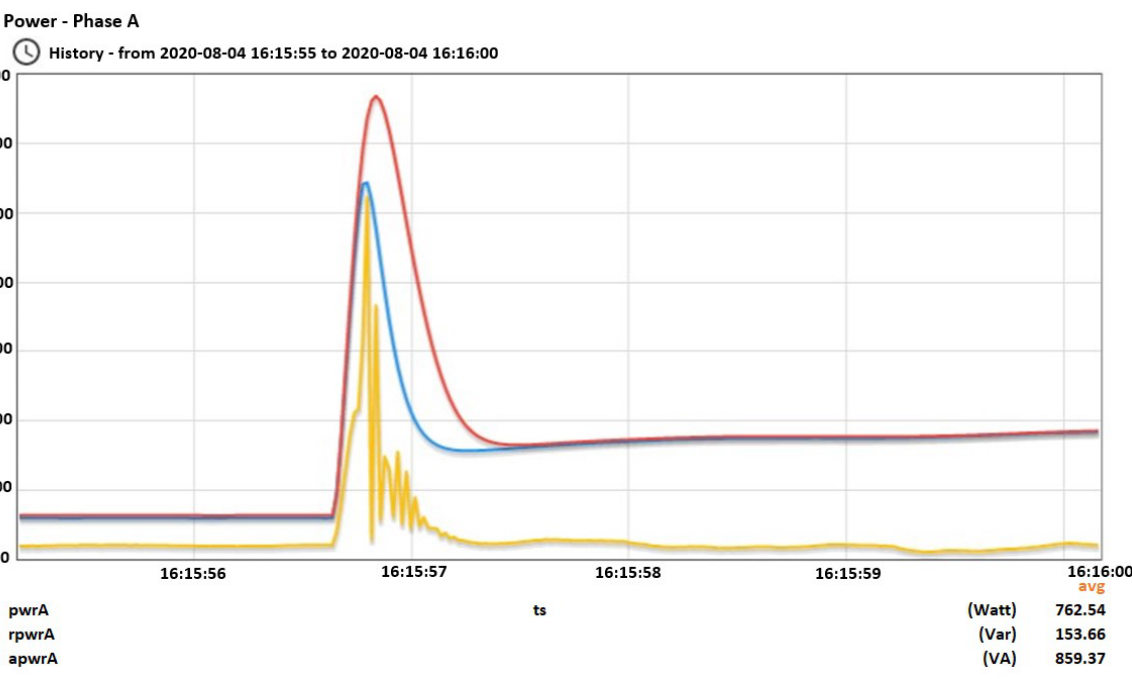
Figure 13. Air-conditioner’s